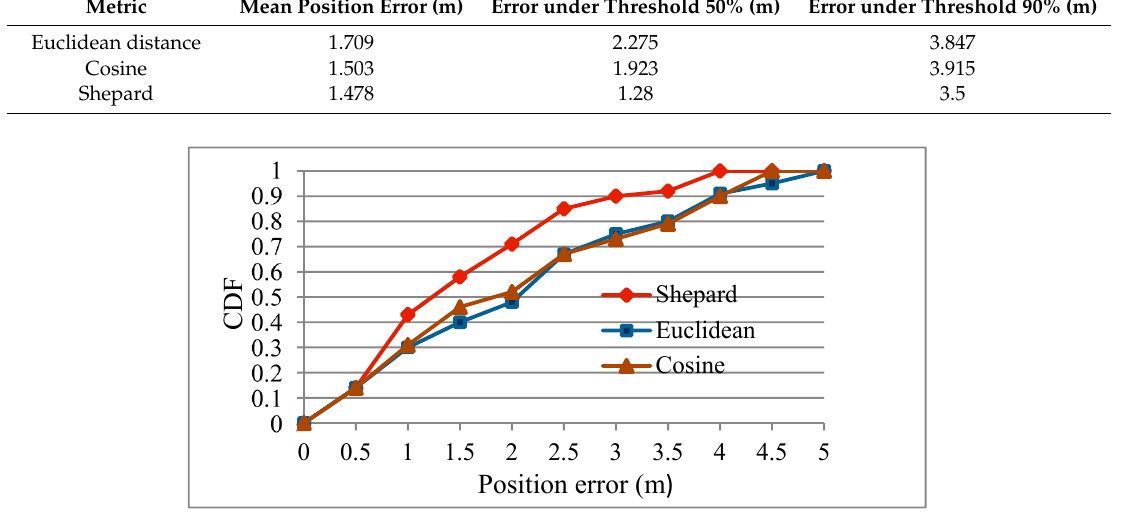
Figure 9. CDF with different similarity metrics.